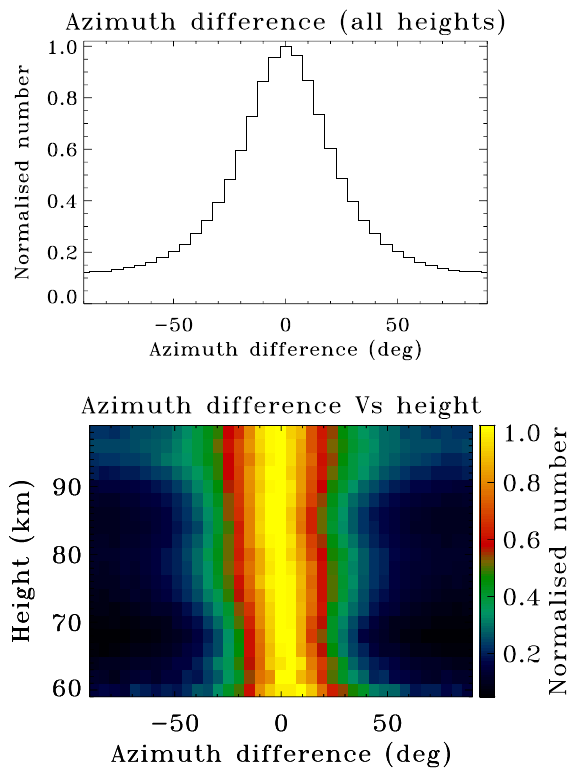
Fig. 3. Difference between effective scattering positions azimuth estimated using least-squares fit and the volume scatter predicted preferred azimuth over the entire observation